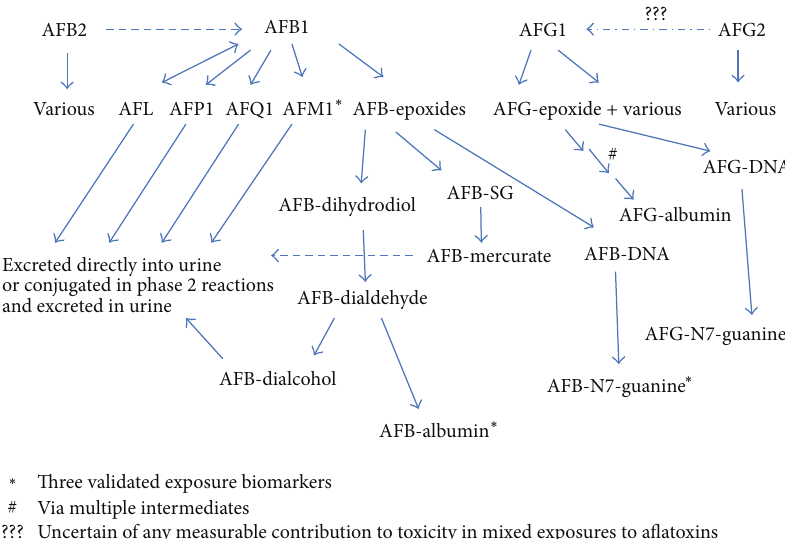
Figure 4: Selected biotransformation pathways for the aflatoxins. Focus on AFB1 biotransformations which are highlighted and indicate the route to the specific biomarkers. Biotransformation of AFB2 to AFB1 will be modest and likely represent less than 1% of the dose of AFB2. The AFG2 pathway is predicted, but likely of low or very modest contribution. Modified from [21,